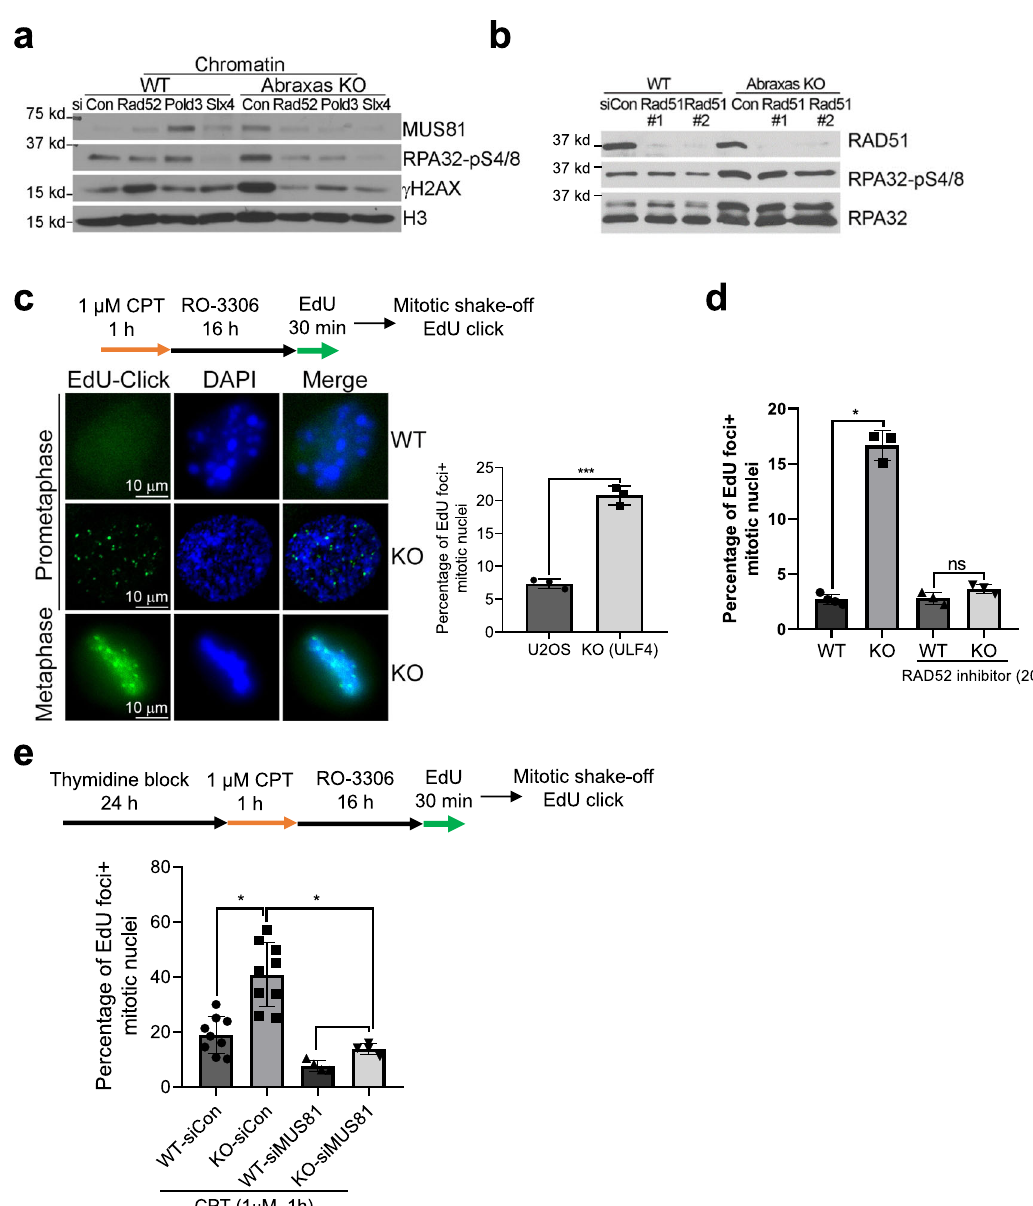
Fig. 6 Abraxas limits mitotic DNA synthesis via RAD52, and POLD3-dependent and RAD51-independent BIR. a Knocking down RAD52 or POLD3 reduced RPA hyperphosphorylation and MUS81 chromatin loading in Abraxas KO cells treated with CPT. Cells transfected with indicated siRNAs were treated with CPT. Chromatin fraction were prepared and used for western blottings. b RPA hyperphosphorylation in Abraxas KO cells treated with CPT is independent of RAD51. c Increased mitotic DNA synthesis in Abraxas KO cells in response to CPT. EdU-click reaction was performed to detect mitotic DNA synthesis. A representative image of EdU foci (left panel) and quanti fi cation of the percentage of EdU foci + cells were shown as mean value ± SD for U2OS ( n = 3 independent experiments with total 292 cells), KO ( n = 3 independent experiments with total 265 cells) examined (right panel). Two-tailed unpaired Student ’ s t -test was used for statistical analysis. *** p = 0.0001. d Inhibition of RAD52 reduces MiDAS in Abraxas KO cells treated with CPT. Cells were treated similarly as above. RAD52 inhibitor was added during EdU pulse labeling and quanti fi cation of the percentage of EdU foci + cells were shown as mean value ± SD for WT ( n = 4 independent experiment with total 183 cells), KO ( n = 3 independent experiment with total 167 cells), WT/RAD52 inhibitor ( n = 3 independent experiments with total 121 cells), KO/RAD52 inhibitor ( n = 3 independent experiments with total 109 cells) examined. * p = 0.042. e MUS81 depletion inhibits mitotic DNA synthesis in Abraxas KO cells treated with CPT. Cells transfected with indicated siRNAs were incubated with thymidine before treatment of CPT and assay for mitotic DNA synthesis. Percentage of EdU foci + cells were quanti fi ed and shown as mean value ± SD for WT- siCon ( n = 9 independent experiments with total 134 cells), KO- siCon ( n = 9 independent experiments with total 108 cells), WT- siMUS81 ( n = 4 independent experiments with total 172 cells), and KO- siMUS81 ( n = 4 independent experiments with total 141 cells). One-way ANOVA Kruskal – Wallis test was used for statistical analysis. * p = 0.0440 and p = 0.0275. See also Supplementary Fig. 6.